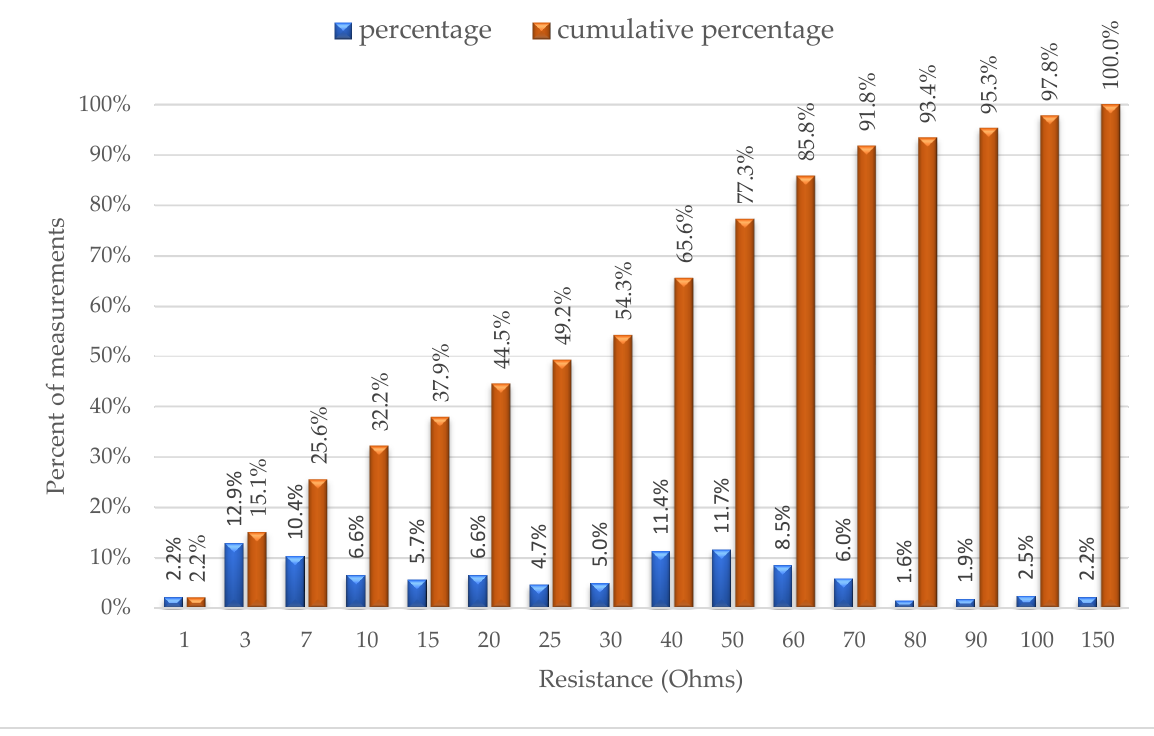
Figure 8. Percentage of wind turbines versus ground resistance value ( blue ) and probability distribution function ( red ).